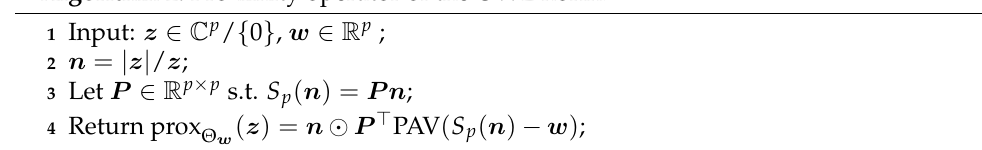
Algorithm 2: Proximity operator of the OWL